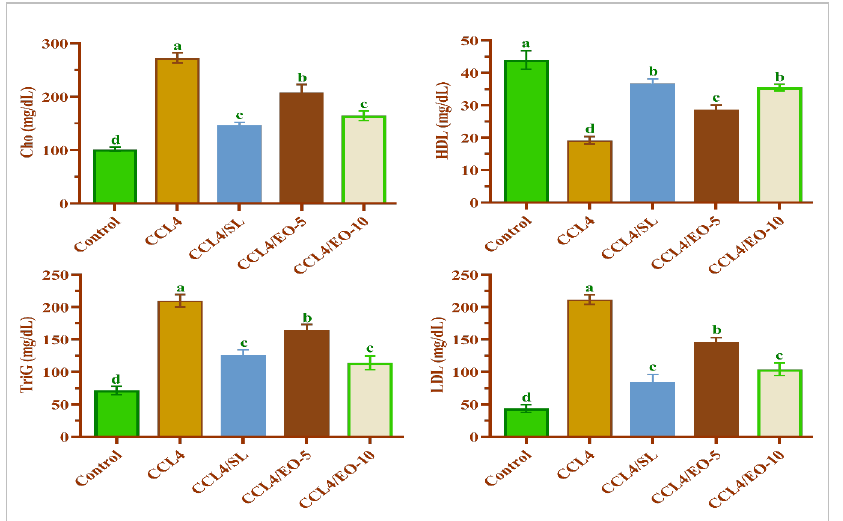
Figure 7. Effect of EO extracted from T. patula on lipid profile of rats treated with CCL 4 . Data represented as mean ± SD ( n = 6). CCL 4 : Carbon tetrachloride; SL: Silymarin; EO-5: Essential oil (5 mg/kg BW); EO-10: Essential oil (10 mg/kg BW); Cho: Cholesterol; TriG: Triglycerides; HDL: High- density lipoprotein; LDL: Low-density lipoprotein. Different letters indicate statistically significant differences between groups at ( p < 0.05).